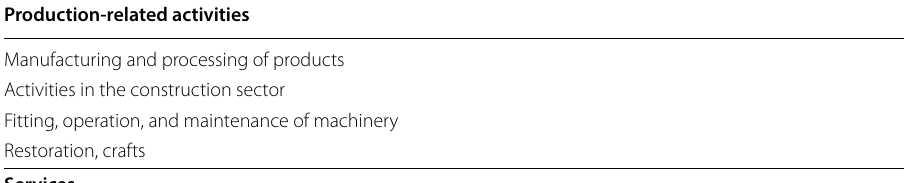
Table 1 List of occupational